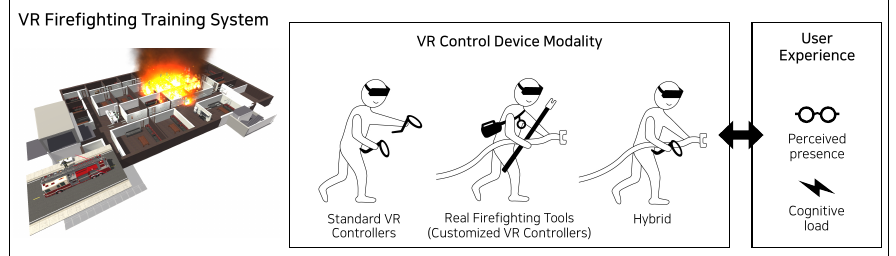
Figure 2. Relationship between the level of VR control device modality and user experience in the VR training context.